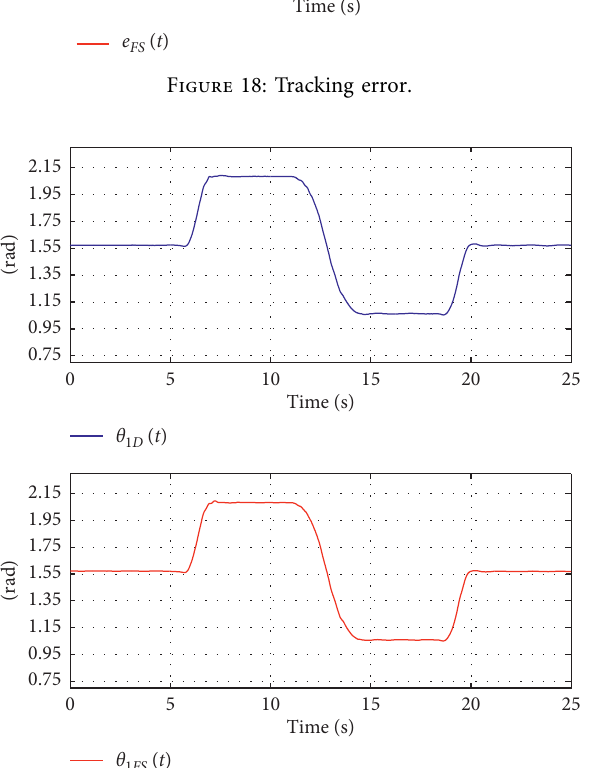
Figure 21: Control input